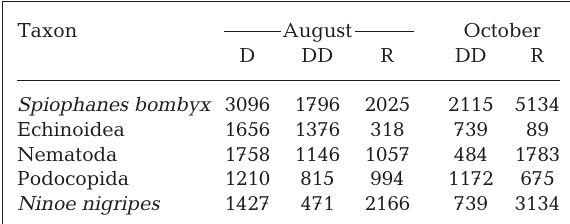
Table 3. Mean density (ind. m −2 ) of the 5 dominant taxo- nomic groups at the 0 m station (directly under the longlines; D: standard density; DD: double density) and at reference